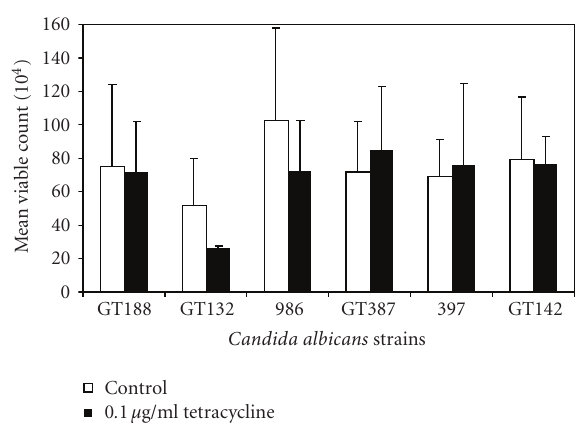
Figure 1: The e ff ect of adding a very low concentration of tetracycline to chemically defined growth medium (YNB) on overnight viable counts of 6 strains of yeast is shown. Three strains of yeast (GT188, 986, and GT132) were previously known to be nonsensitive to 17 β -estradiol (did not show increased growth yield in the presence of 1 × 10 − 5 M/L 17 β -estradiol), and 3 strains (GT387, 397, and GT142) were previously shown to be sensitive to growth yield stimulation in the presence of 17 β -estradiol. Standard deviations from triplicate determinations are shown by error bars. White bars represent growth in YNB, and black bars represent growth in YNB with 0.1 μ g/mL tetracycline.